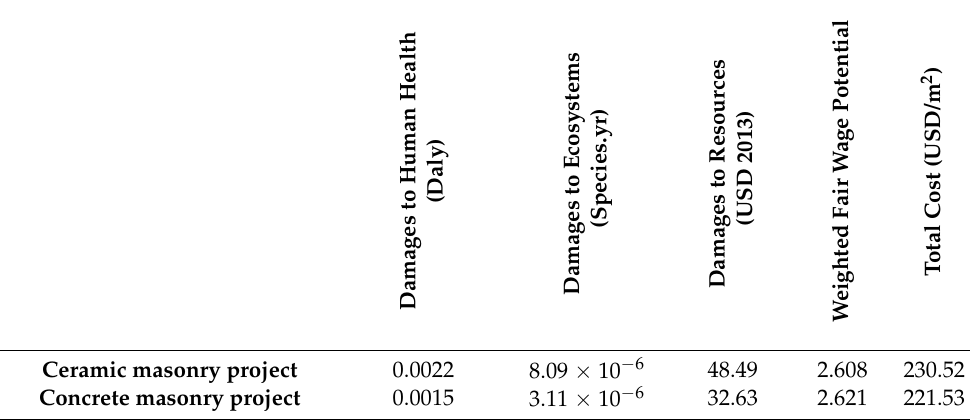
Table 9. Hierarchical perspective: values of the criteria for determining